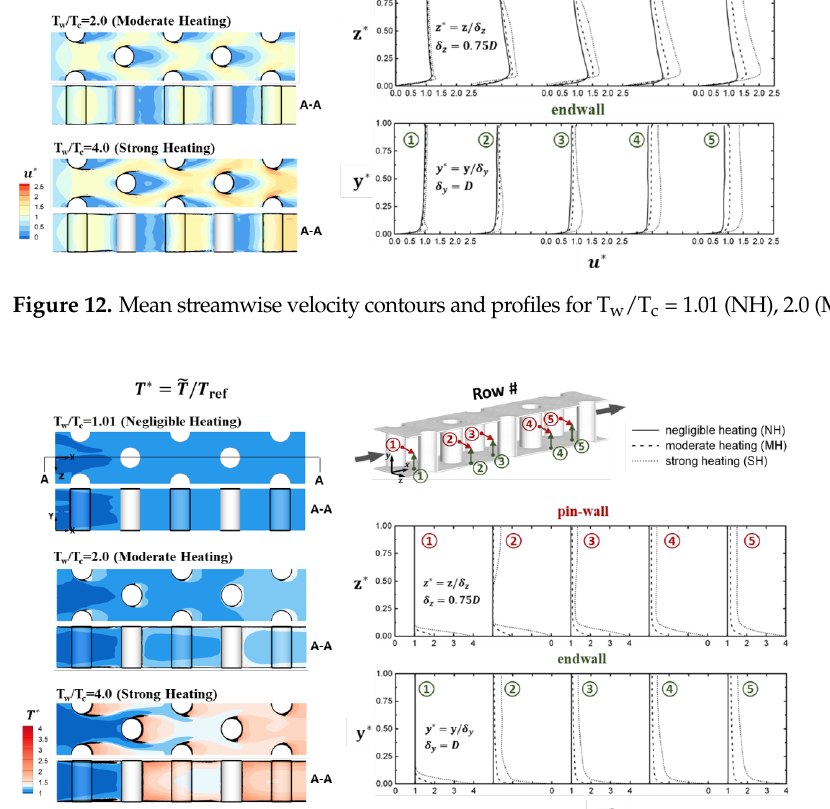
Figure 15. Temperature variance profiles for NH, MH, and SH wall heating. 5.2. Turbulent Statistics Figure 16 shows the “total” turbulent kine tic energy normalized by the reference ve- locity ( K* ) as a function of heat load. The “total” K is the sum of the turbulent kinetic energy resolved by LES and the “unresolved” turbulent kinetic energy modelled by the SGS. The turbulent kinetic energy was generated in regions of high mean velocity gradi- ents – although there was a delay between the gradients and the production. Regions of high gradients were next to walls created by vortex shedding, horseshoe vortices, and the shear layer where different flow structures interacted. With the heat load at T w /T c = 1.01